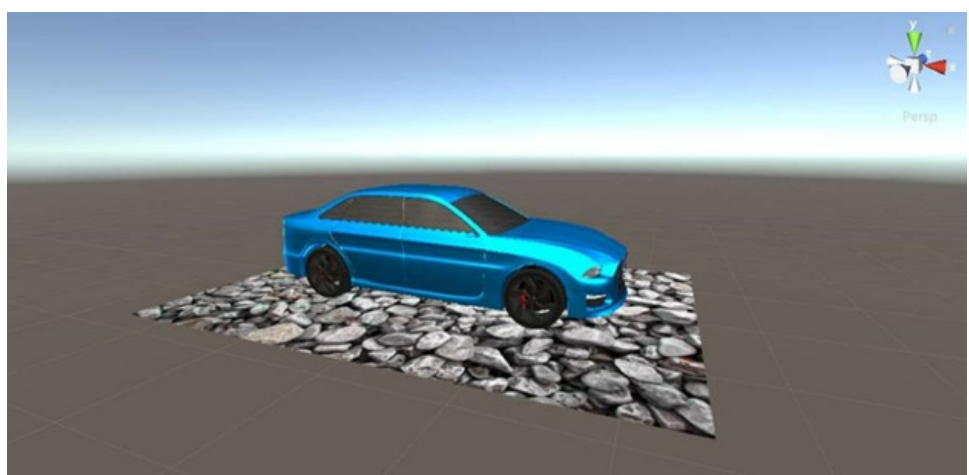
Figure 12. Superimposition of 3D model on image target in Unity environment.